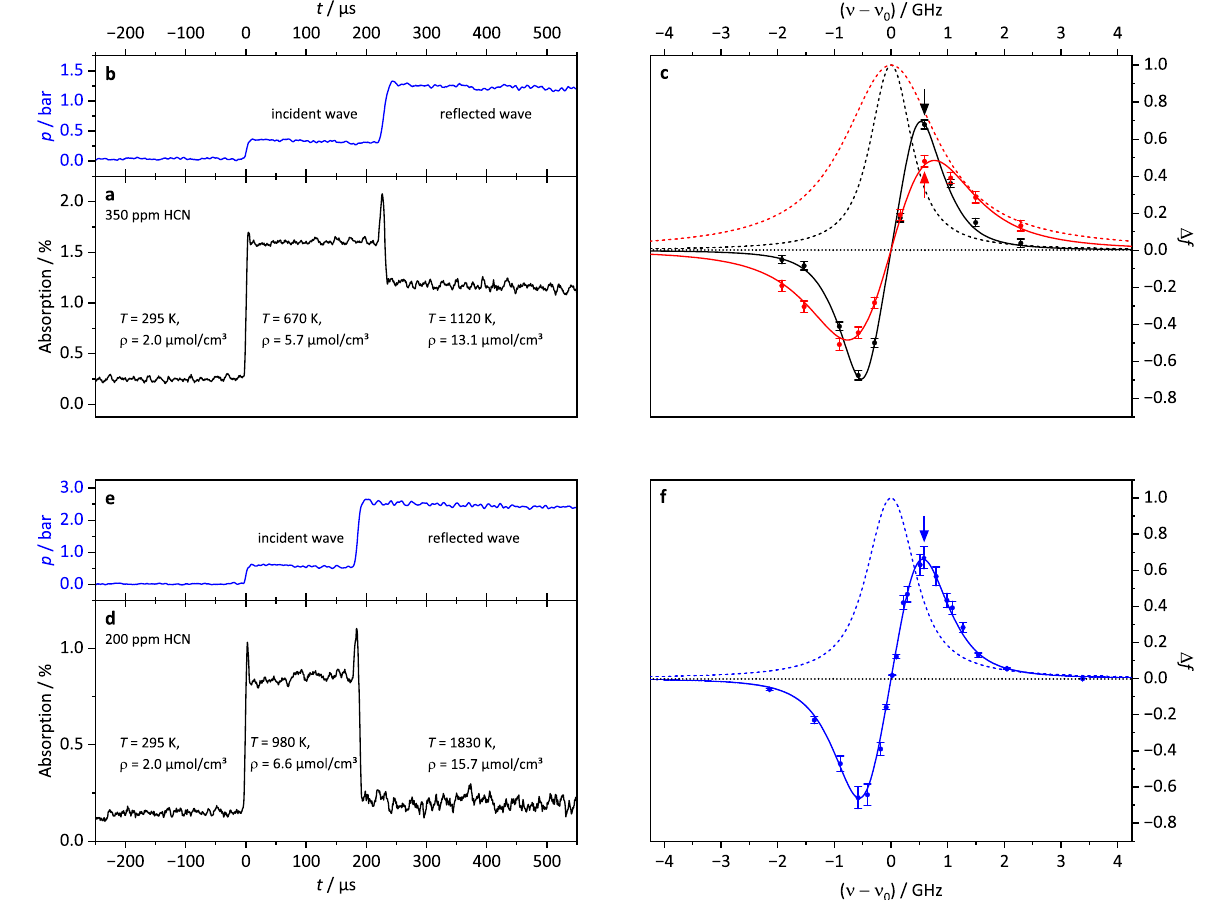
Figure 2. Typical measured HCN traces ( a , d , 2 MHz sampling rate, 20 points moving average), the corresponding pressure traces ( b , e ), and the resulting line profiles ( c , f ) for the P(26) absorption line at ˜ ν = 3228.049 cm − 1 . The data points extracted from the experiments shown in the left plots are highlighted in the right plots with arrows. The solid and dashed curves in the right plots correspond to the simulated FM profiles and their respective underlying absorption lineshapes for T ≈ 670 K and p ≈ 0.32 bar (black), for T ≈ 1120 K and p ≈ 1.22 bar (red), and for T ≈ 980 K and p ≈ 0.54 bar